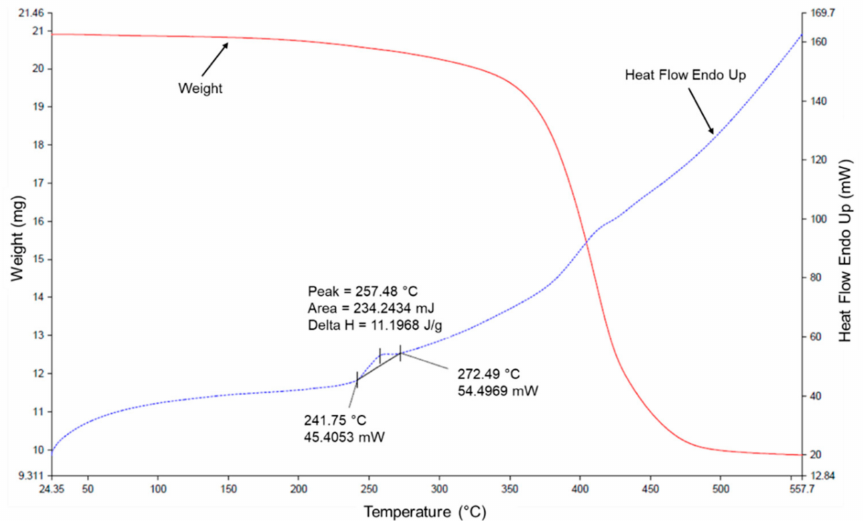
Figure 5. Thermogravimetric curves TGA of PFELT.